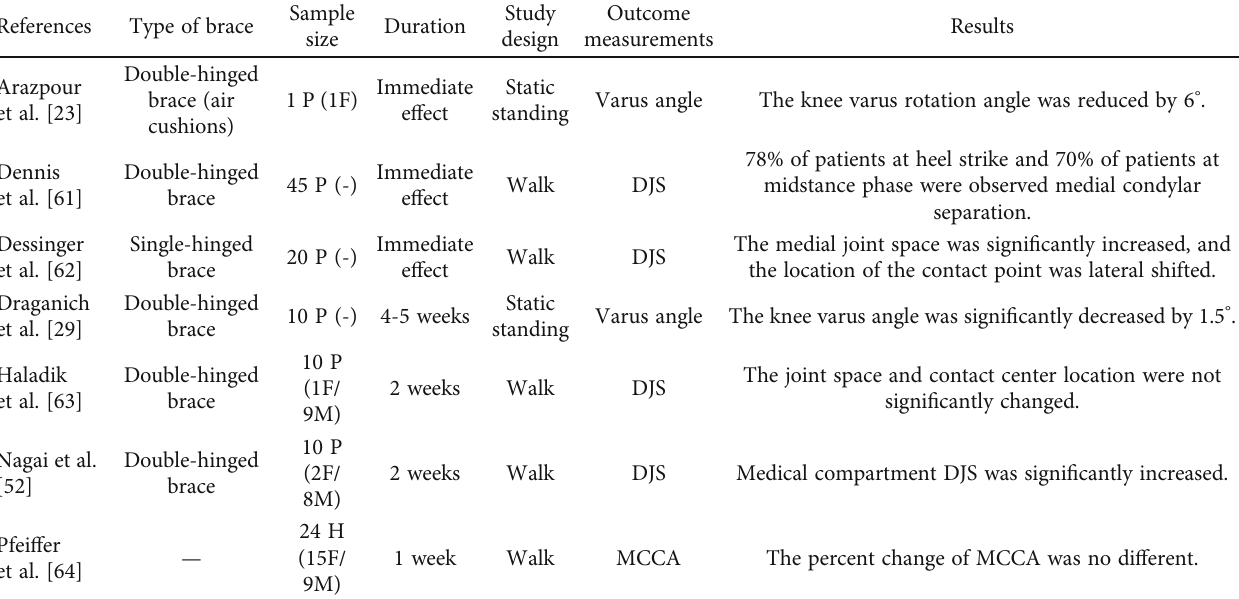
Table 5: Studies that evaluated the e ff ect of knee brace on morphological results in medial